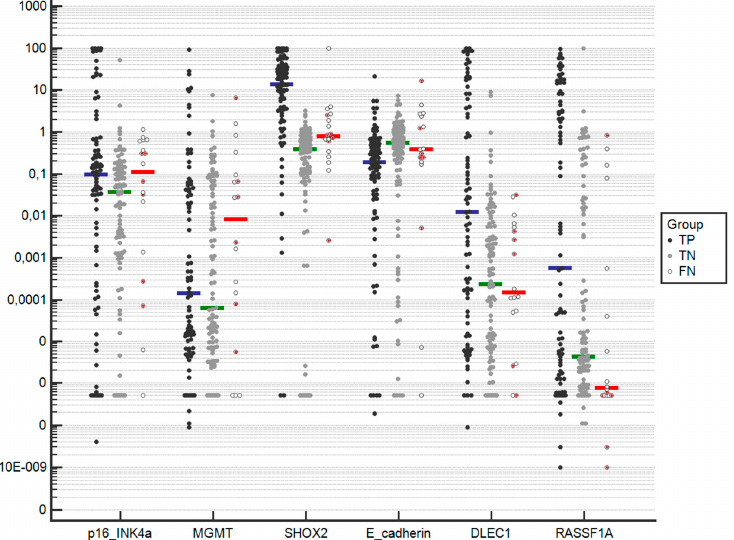
Figure 1. Representation of the methylation percentage of the six candidate genes analyzed, grouped according to EBUS-TBNA and final diagnosis. TP: true positive; FN: false negative; TN: true negative. Median methylation is represented with a horizontal blue line for TP, a green line for TN, and a red line for FN. The six FN patients in which malignancy was not histologically confirmed are represented as filled red circles. In the y-axis, Please change 10E-009 into scientific notion 1.0 × 10 − 9